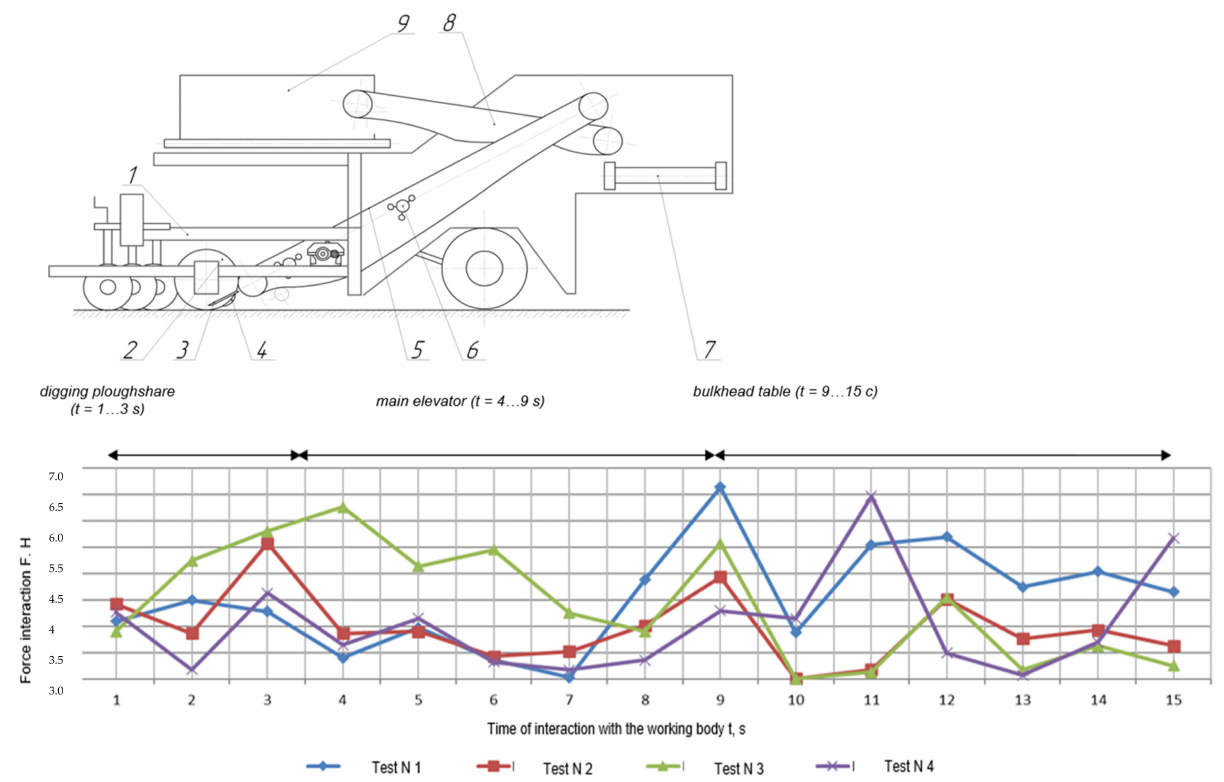
Figure 10. Structural and technological scheme of the Bolko combine harvester: 1—frame; 2— vertical discs; 3—digging ploughshare; 4—support wheel; 5—main elevator; 6—shaker; 7—transverse elevator; 8—bulkhead table; 9—hopper